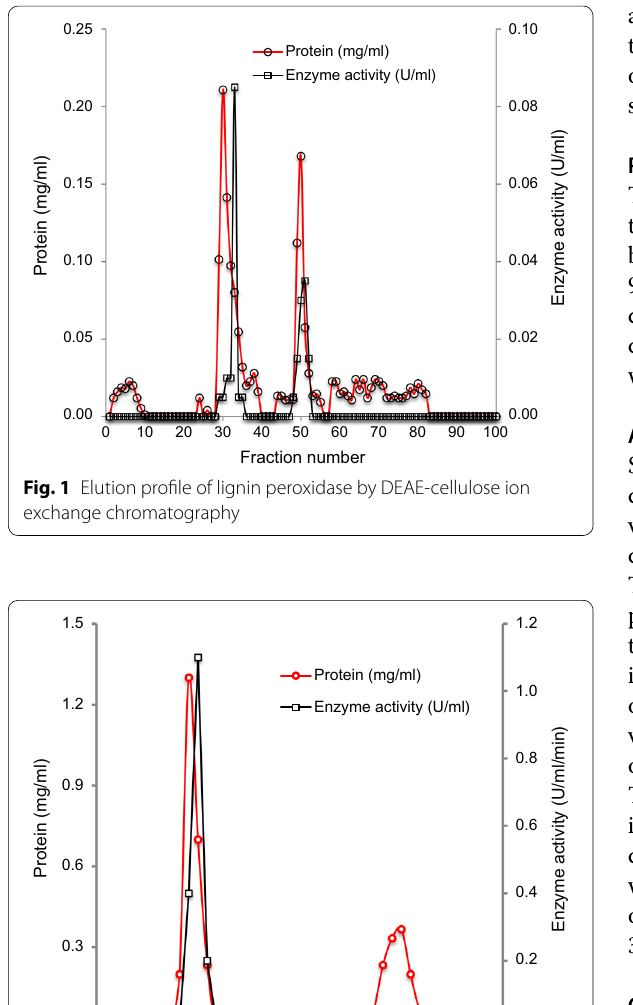
Table 1 summarizes the purification profile of the